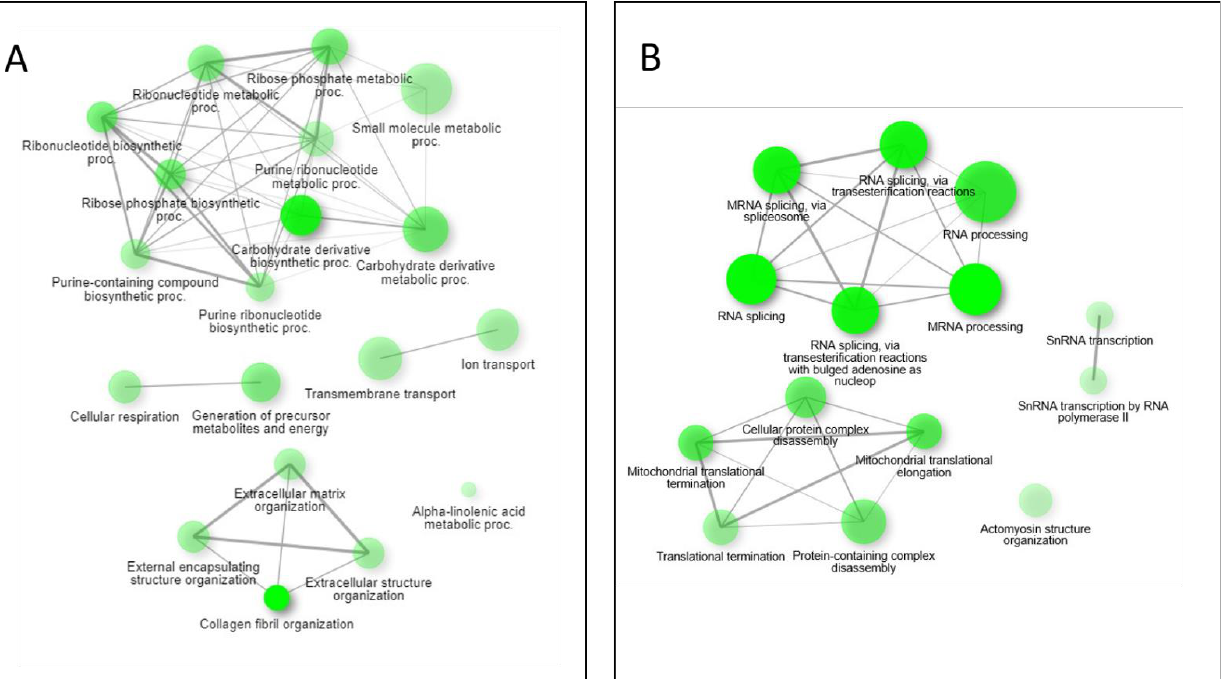
Figure 7. Pathway network mapping of enriched pathways upregulated ( A ) and downregulated ( B ) at the 24 h mark. Darker nodes are more significantly enriched gene sets. Bigger nodes represent larger gene sets. Thicker edges represent more overlapped genes.